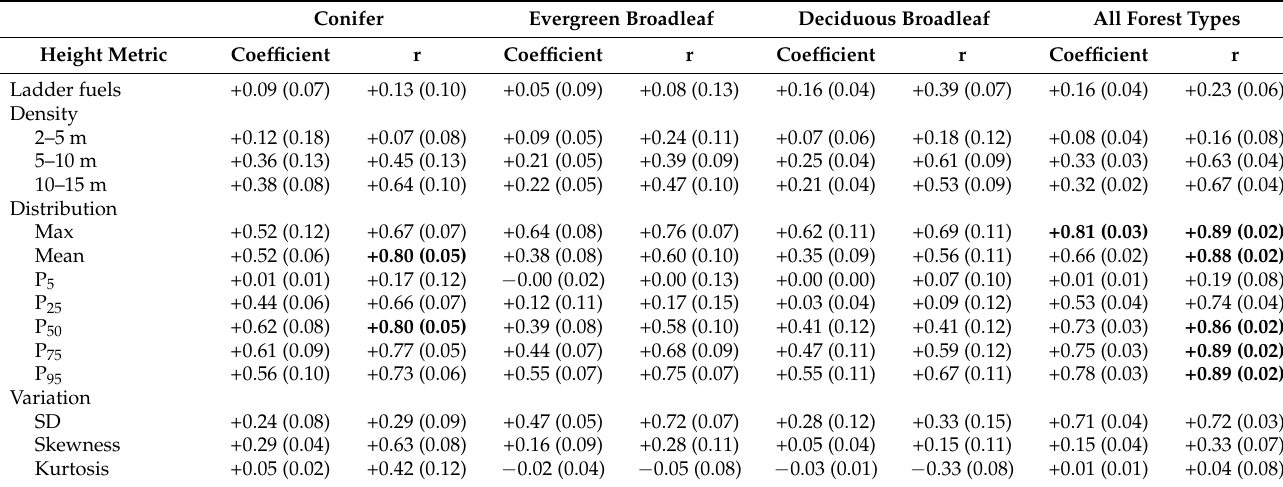
Table 2. Regression slope coefficients and Pearson’s r correlation coefficient for point cloud grid metrics comparison between airborne laser scanner (ALS) data and unoccupied aerial system structure from motion (UAS-SfM) height normalized using the UAS-SfM digital terrain model (DTM). Metrics P 5 , P 25 , etc. represent height percentiles. Values given are mean (standard error) of 10,000 bootstrap replicas of 100 unburned plots per forest type. Coefficient and r values greater than 0.8 are shown in bold.